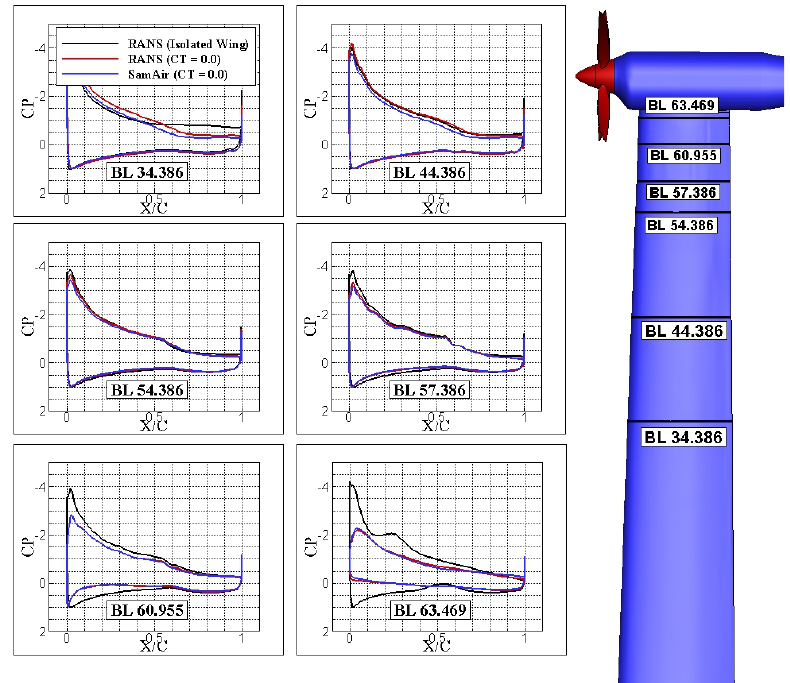
Figure 12. Surfaces pressure data of propeller-off predictions at α = 15 ◦